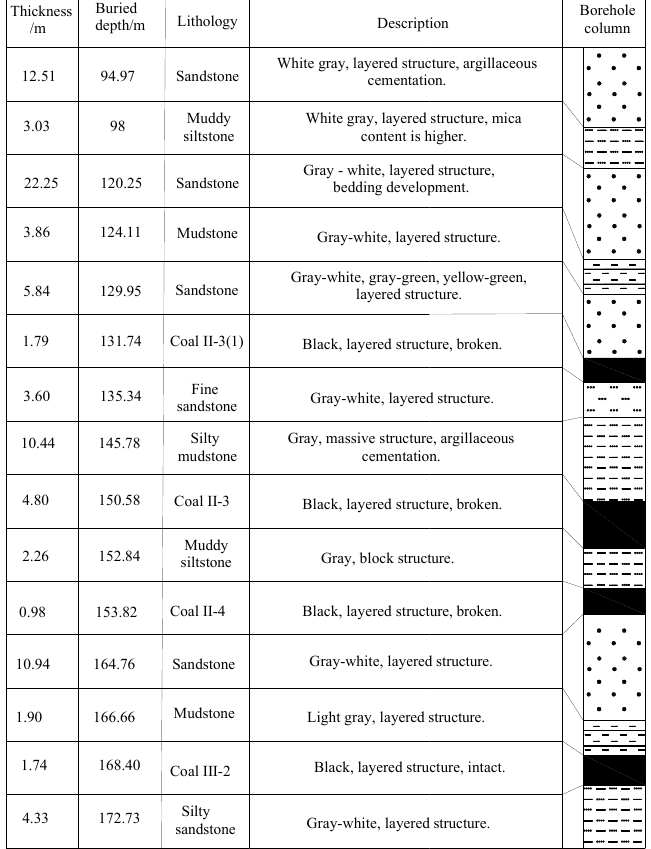
Borehole column